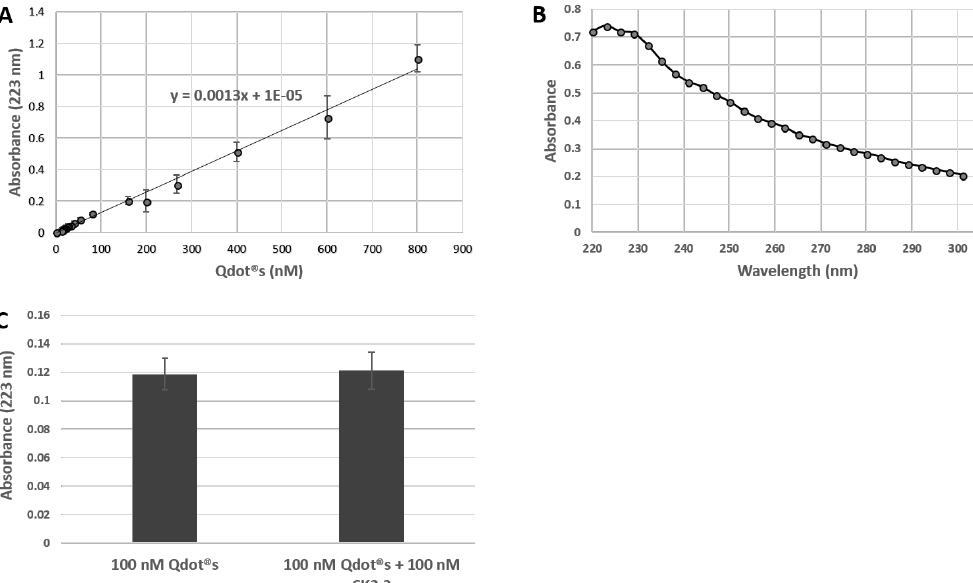
Figure 4. UV/VIS spectra were collected by drop-casting 2 μL of sample onto the pedestal of ND-1000 Spectrophotometer. ( A ): Standard curve of Qdot® s representing the absorbance of known concentrations of Qdot® s (0–800 nM) at 223 nm; ( B ): Sample UV/VIS spectra of unconjugated Qdot® s with maximum wavelength at 223 nm; ( C ): Graphical representation of absorbance at 223 nm by 100 nM of Qdot® s, compared to solution mixture containing 100 nM of Qdot® s and 100 nM of CK2.3.